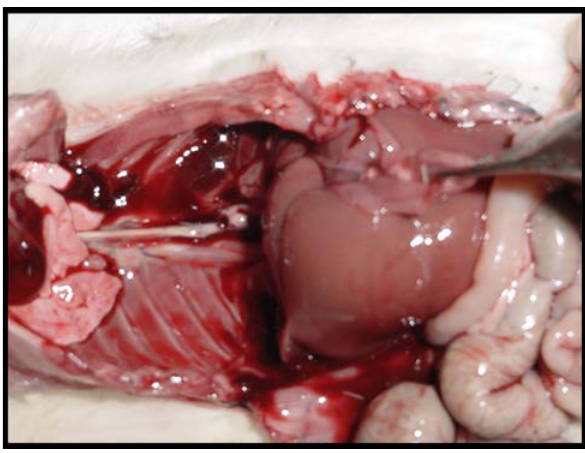
FIGURE 6 - Picture of hepatectomy on animal in the experiment group.